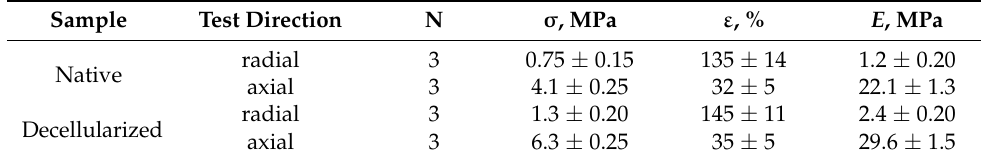
Table 2. Mechanical characteristics of native and decellularized samples of bile